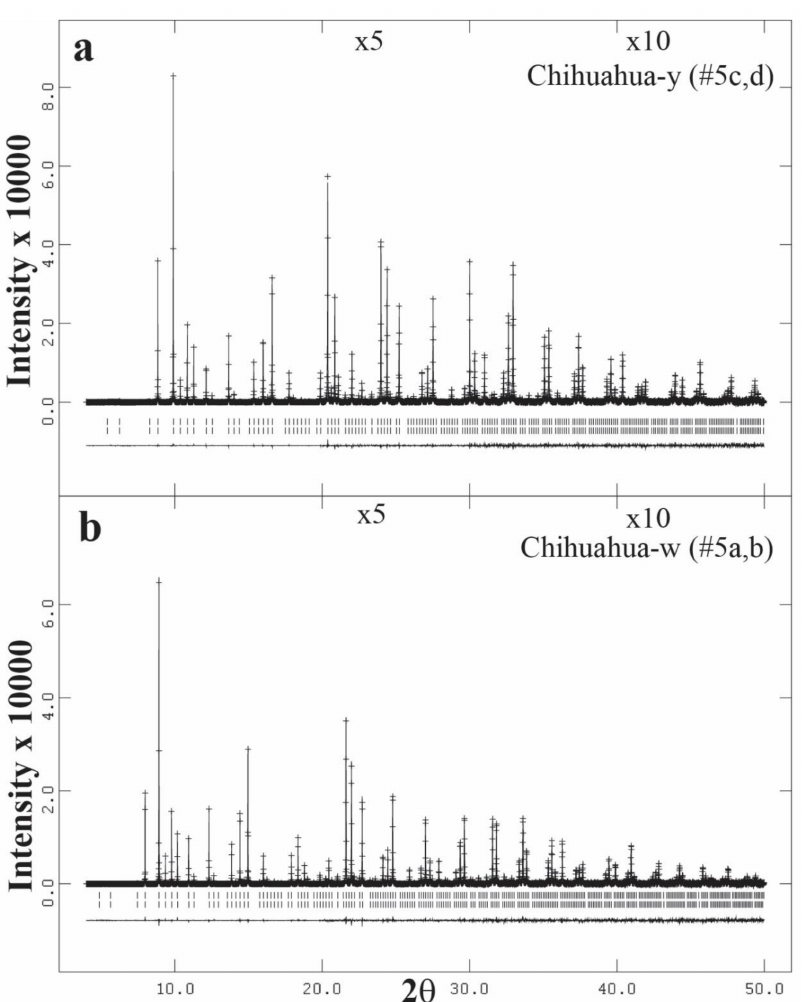
Figure 13. Complete HRPXRD traces for sample-5 from Chihuahua, Mexico. The trace in ( a ) is from the white part of the crystal and that in ( b ) is from the yellow core of the crystal. Data for sample-4 was modelled using two slightly different cubic phases.